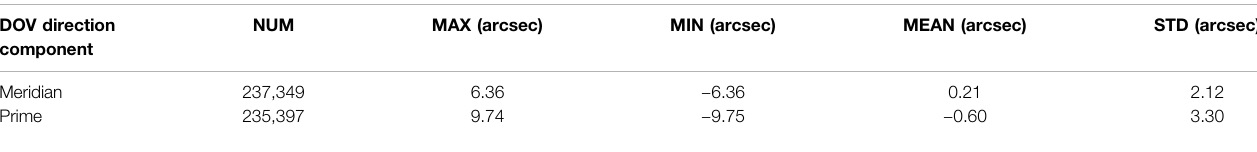
TABLE 9 | Statistical information of ATVD directional component after gridding. DOV direction